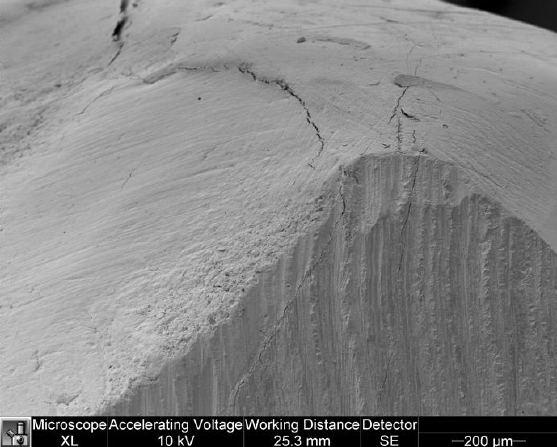
Figure 8. Marginal adaptation in a specimen of the control group. Table 5. Overhangs in the study